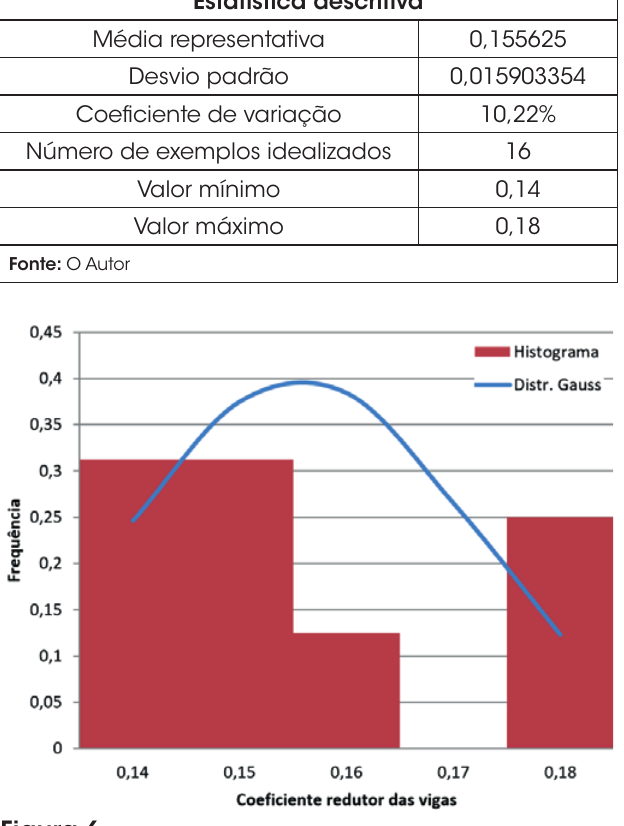
Figura 7 Distribuição de Gauss x Histrograma para a rigidez dos pilares nos exemplos com 2